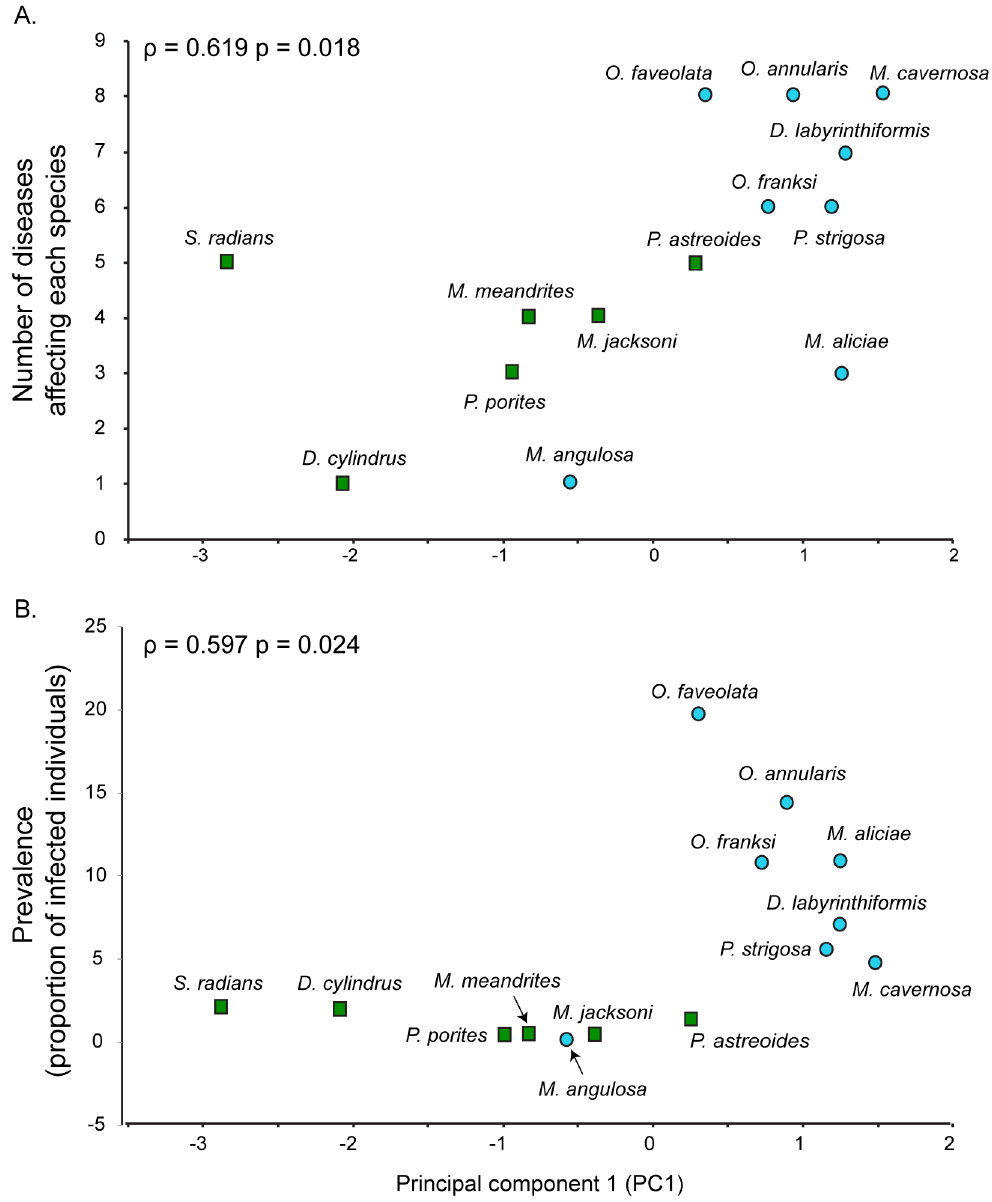
Figure 3. Correlation between (A) number of diseases (number of diseases affecting each coral species) and (B) prevalence (proportion of individuals infected in the population of a given species) with constitutive levels of immunity as measured with the Principal Component 1 (PC1) obtained from Principal Component Analysis of six immune measures (prophenoloxidase, melanin concentration, superoxide dismutase, peroxidase, catalase and inhibition of bacterial growth). The correlations were determined with the Spearman’s rank order index ( r ) for both disease susceptibility and prevalence. Green squares represent older, and blue circles modern lineages.